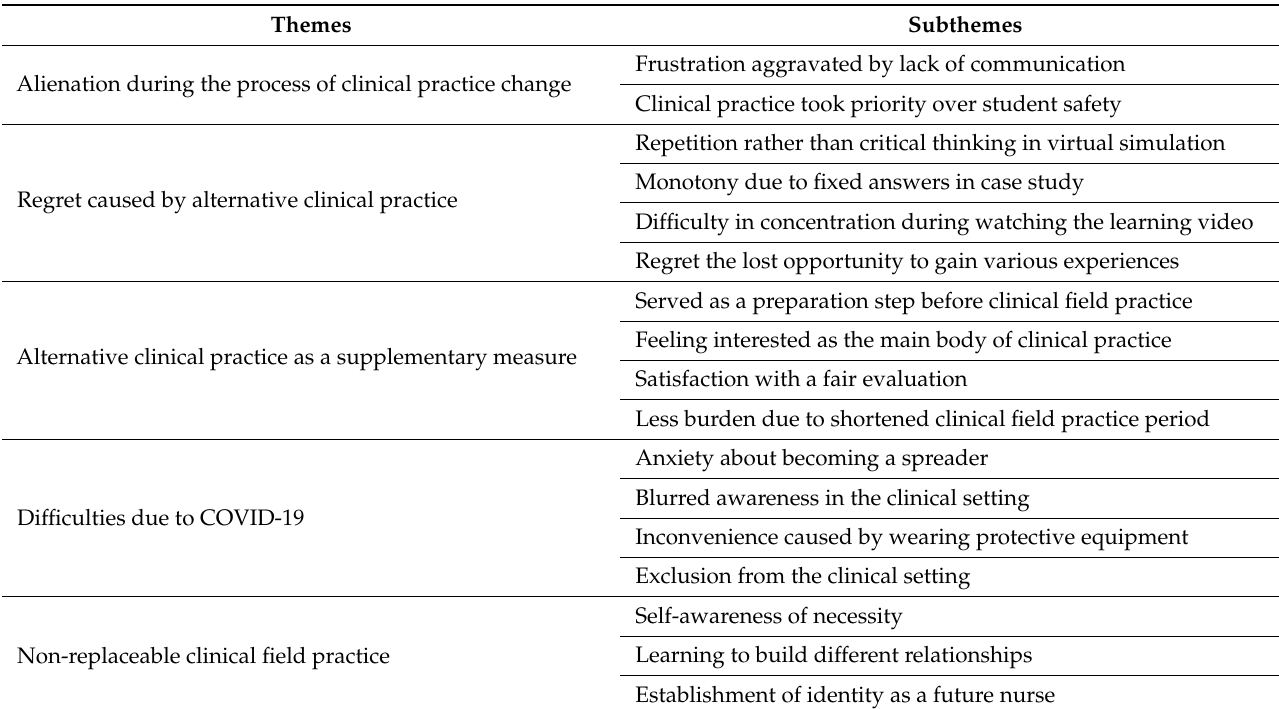
Table 2. Theme and subthemes from student interview responses.